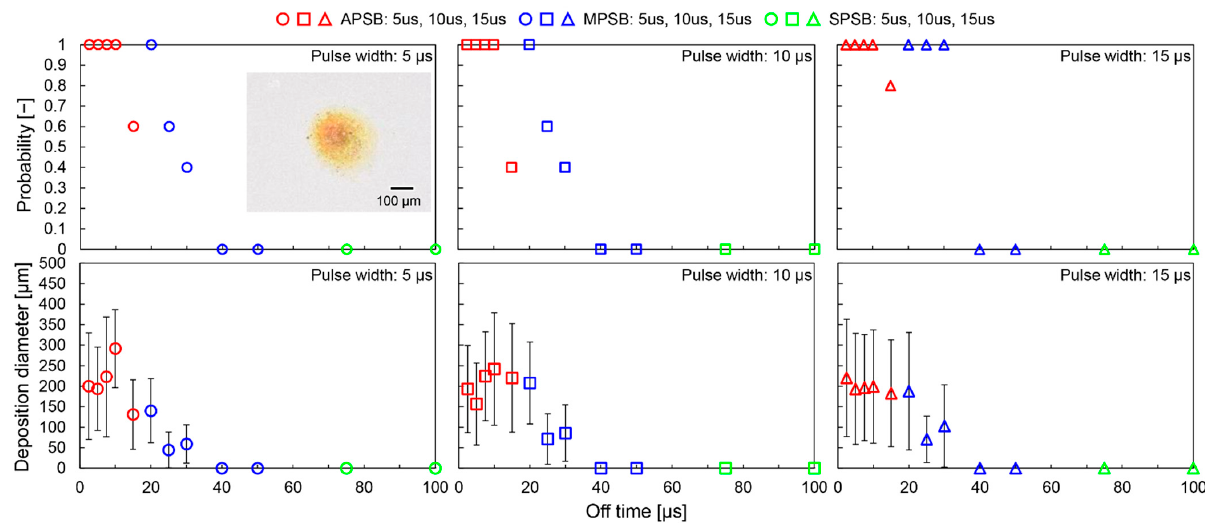
Figure 5. Results of the deposition probability and diameter with varying off time. The plots are color coded according to the bubble generation mode in Figure 4. The voltage was 700 V.